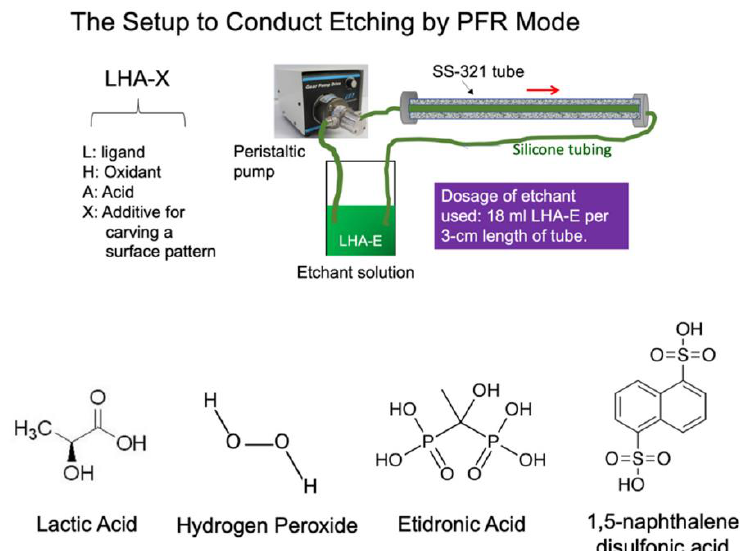
Figure 1. Schematic of the setup to conduct chemical etching using the plug flow reactor (PFR) mode (upper). The structures of the L (lactic acid), H (hydrogen peroxide), and X (etidronic acid or 1,5-naphthalene disulfonic acid) are